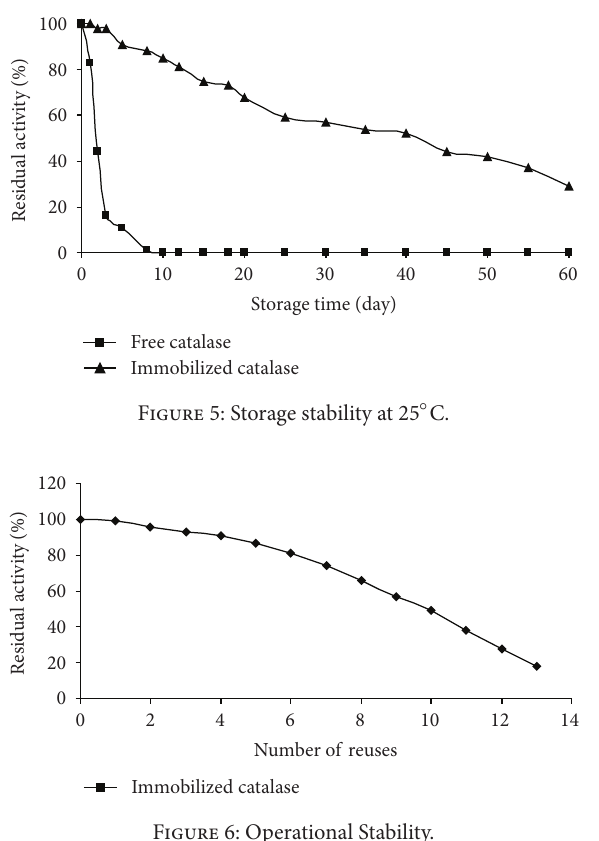
Immobilized catalase F 6: Operational